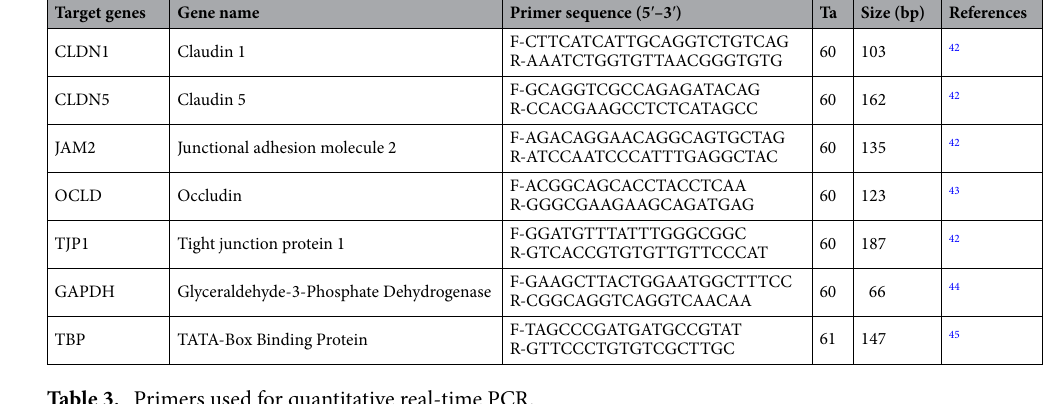
Table 3. Primers used for quantitative real-time PCR.